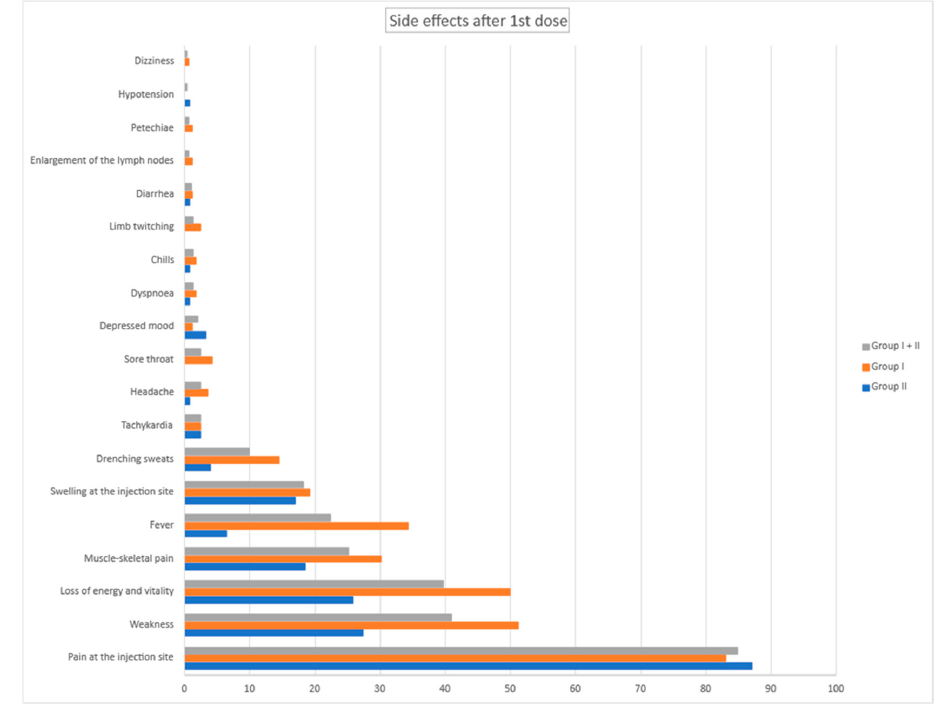
Figure 2. Side effects after 1st dose for group I and group II in %.